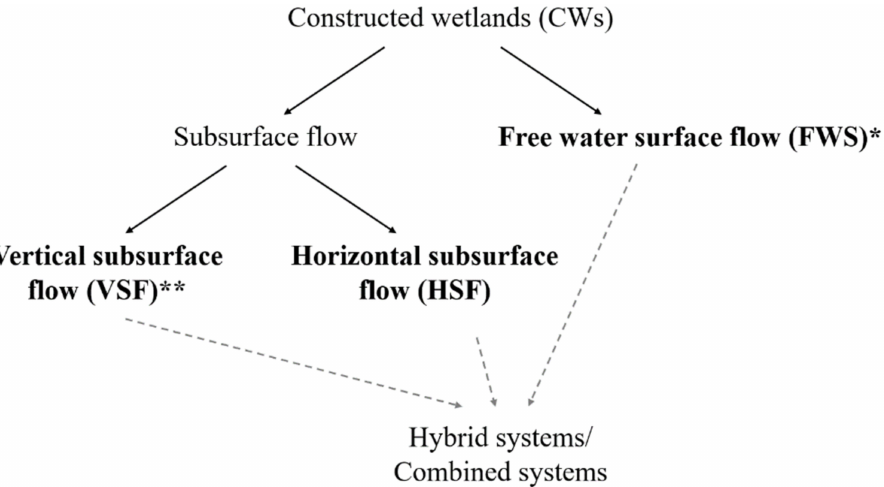
Figure 2. Simplified classification of constructed wetlands (CWs) for wastewater treatment (from [68] with some modifications); * FWS CWs may contain different types of vegetation, such as emergent, submerged, free floating and floating-leaved plants; ** VSF CWs can be characterised by different wastewater flows: up, down and